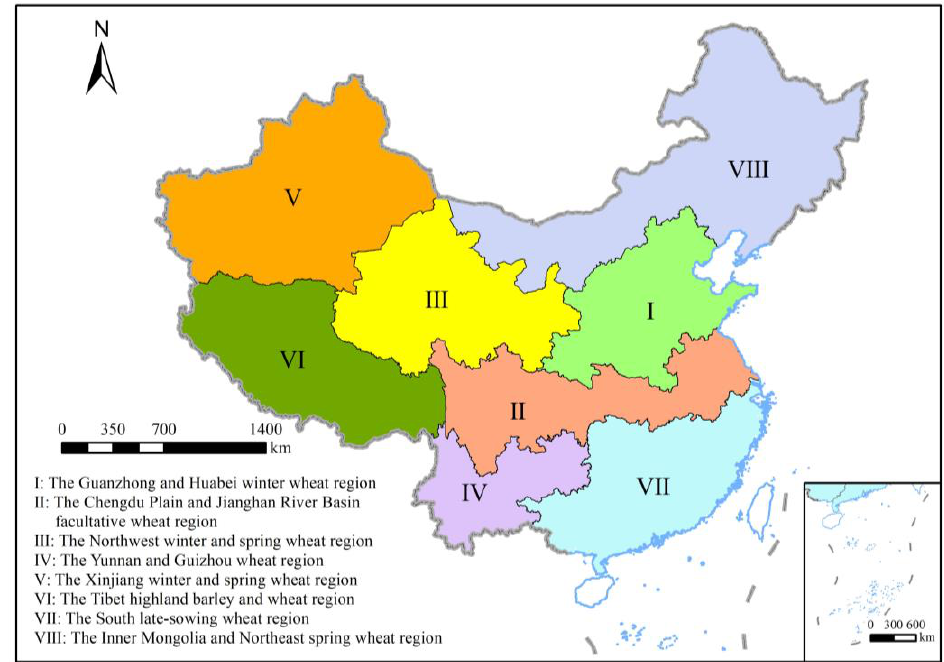
Figure 6. Wheat stripe rust ecological zones in China [9]. Adapted with permission from Ref. [9]. 2014, John Wiley and Sons.